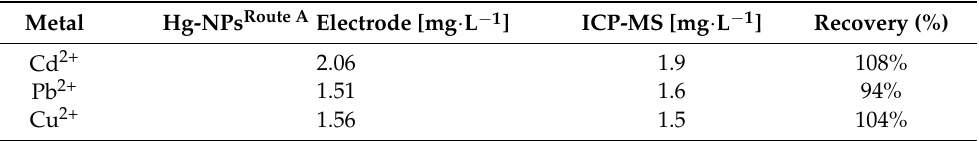
Table 4. Results of the standard addition of the sample, comparison with a reference method (ICP-MS) and the recovery values. The recovery values were calculated from the quotient between the result of our sensor and the ICP-MS